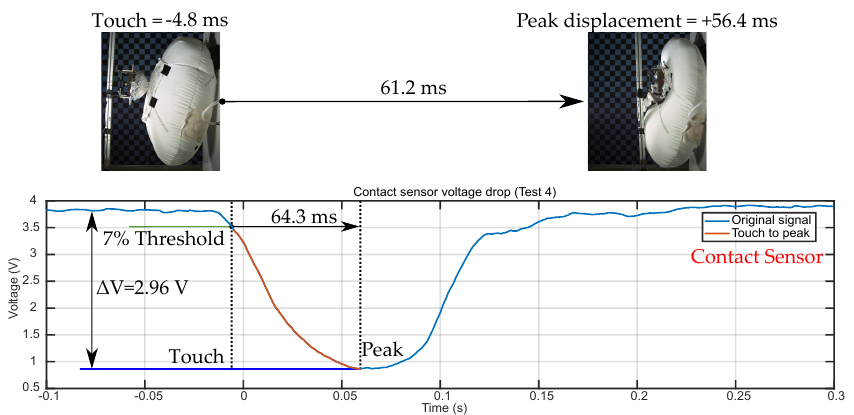
Figure 13. Sensor benchmarking.